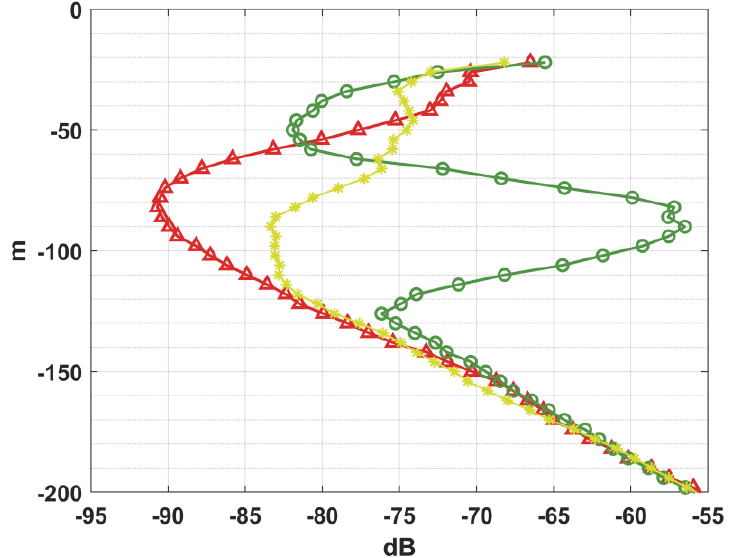
Figure 8. Examples of selected acoustic profiles correspondent to the obtained false color composition reported on the map in Figure 7a and indicated with the markers. Profiles were smoothed with a 5-point moving average.